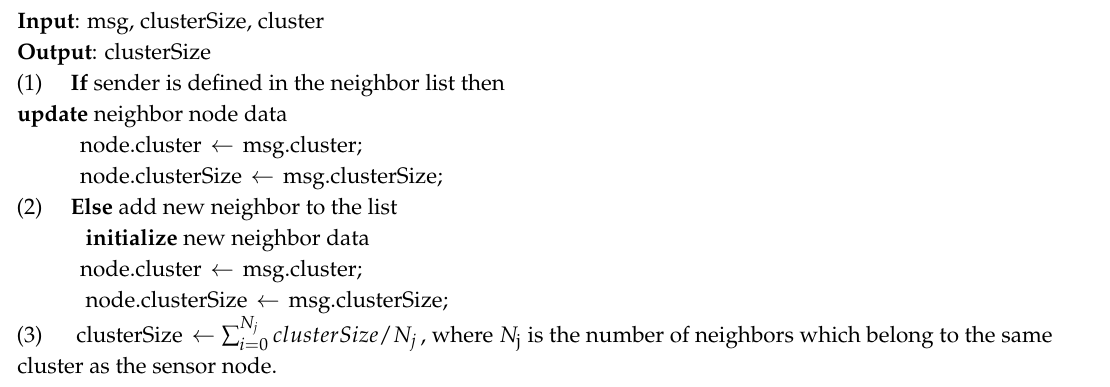
Algorithm 6 . Handling of unicast messages by the UAV function